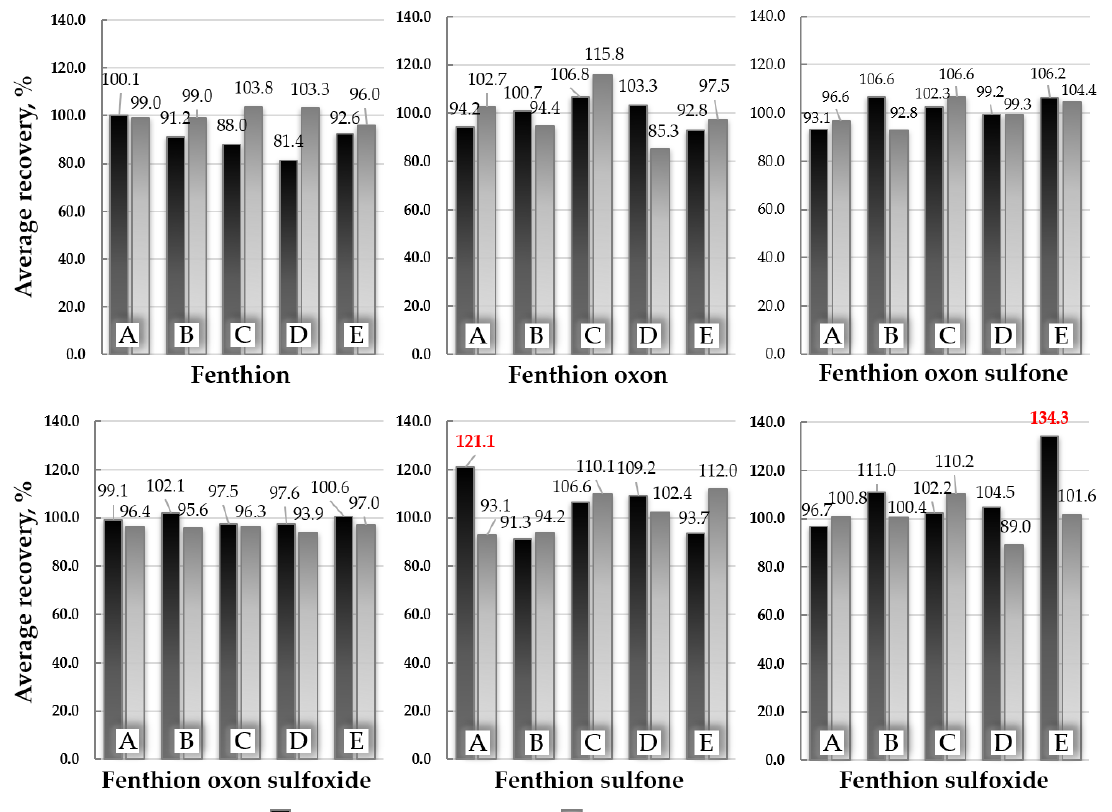
Figure 4. Average recoveries of fenthion and its metabolites obtained by the different extraction methods (the non-buffered QuEChERS (quick, easy, cheap, effective, rugged, and safe) method vs. the citrate-buffered QuEChERS method) at 0.1 mg/kg spiking level ( n = 3) in various matrices: ( A ) brown rice, ( B ) chili pepper, ( C ) orange, ( D ) potato, and ( E ) soybean.